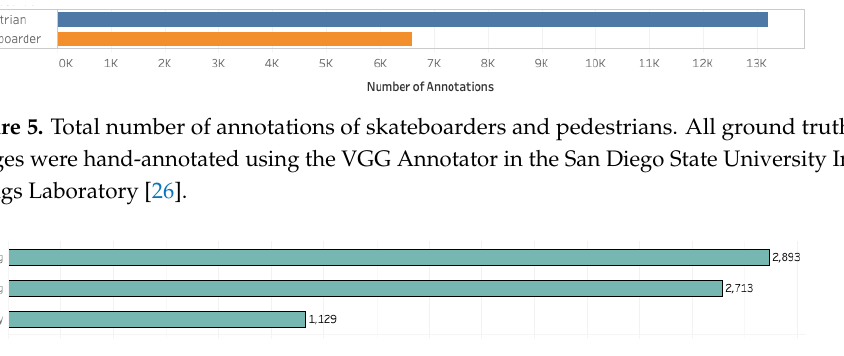
Figure 6. Image data according to time of the day. Only evening images were used, as a proof of concept, since morning and mid-day images contain shadows which impede the performance of the object detection model. A fast shadow removal algorithm can be used to remove shadows before feeding to a deep learning